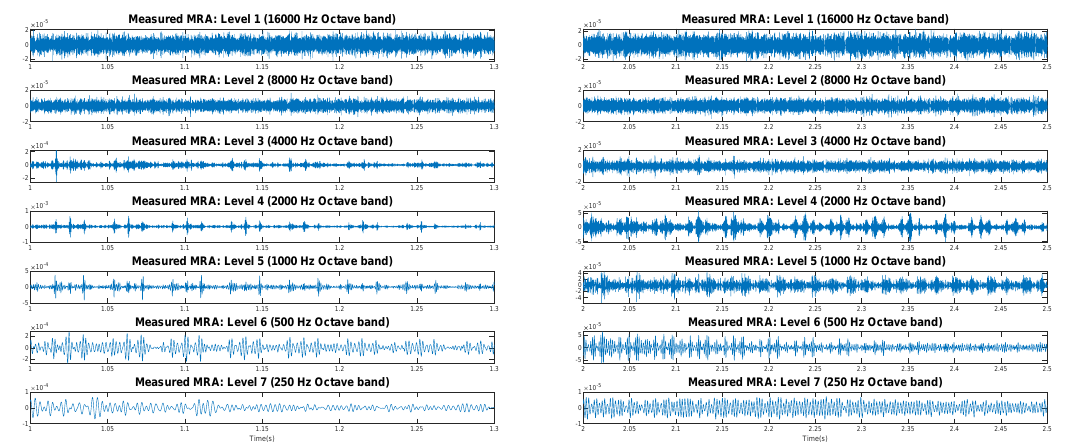
Figure 12. MRA levels 1–7, calculated using measured data sampled at 45.254 kHz from R04, representing octave bands 250–16,000Hz, t = 1–1.3s and 2–2.5s. Based on these plots, the Level 4 MRA was identified for use in the presented wavelet